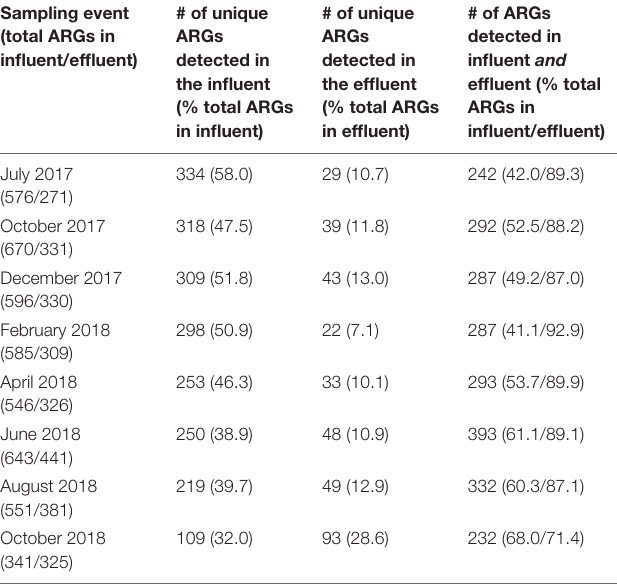
TABLE 4 | ARGs detected only in the effluent that were also detected in the October 2018 sampling, which yielded the highest number of unique ARG detections determined by metagenomics.